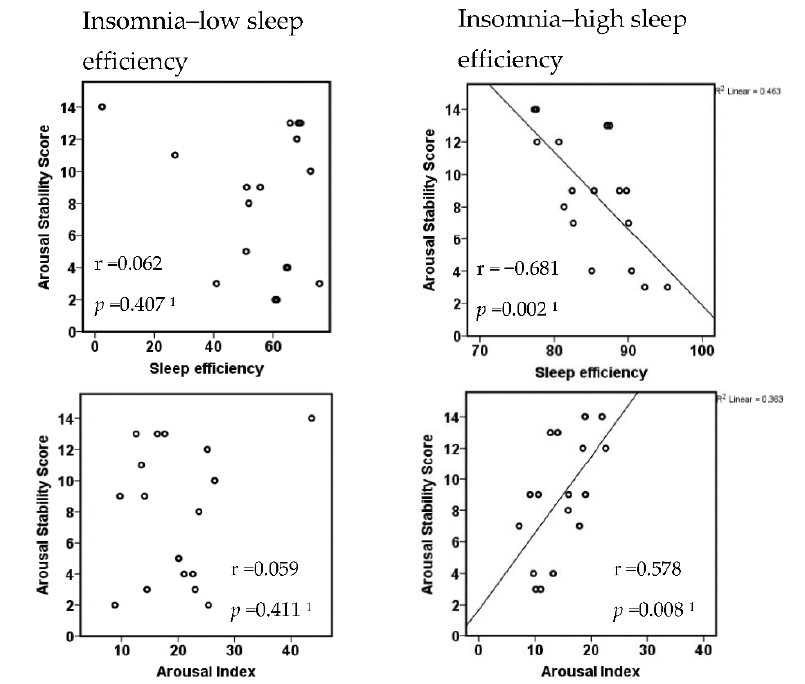
Figure 4. Correlation of the arousal stability score with polysomnographic sleep measures in insomnia subgroups with high versus low sleep efficiency. 1 Spearman correlation, one-sided testing corresponding to directed hypothesis.